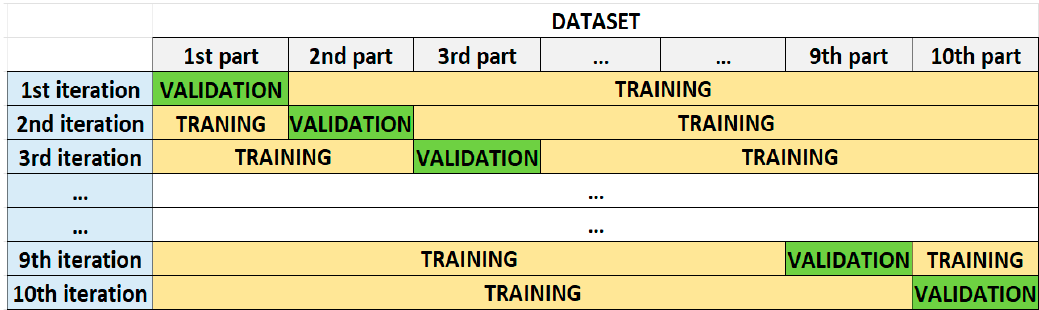
Figure 3. Stages of 10-fold cross validation. (Illustrations by the authors).